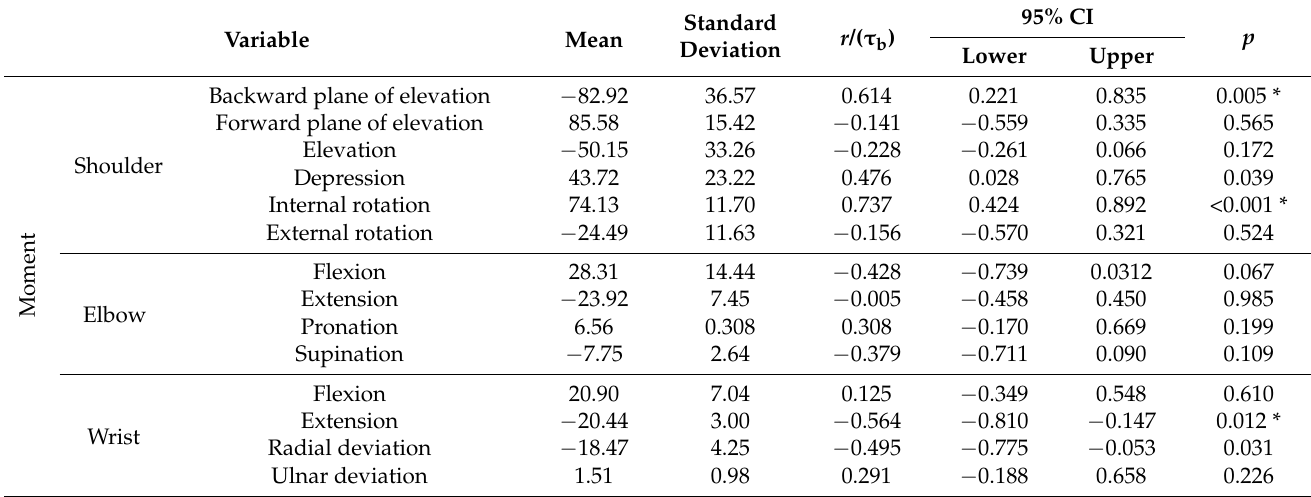
Table 1. Peak moment data during the swing phase at the shoulder, elbow and wrist joints for each participant’s fastest